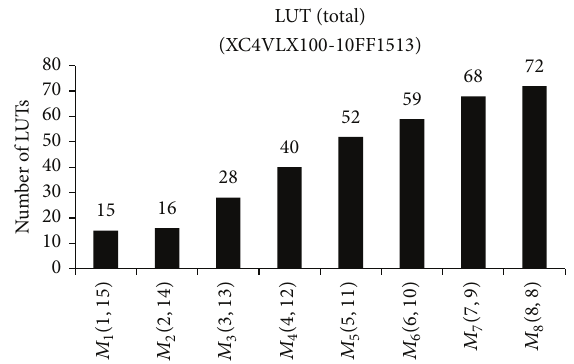
Figure 6: Actual LUT utilization corresponding to 8 different multiplications with the same product bit-width (16).